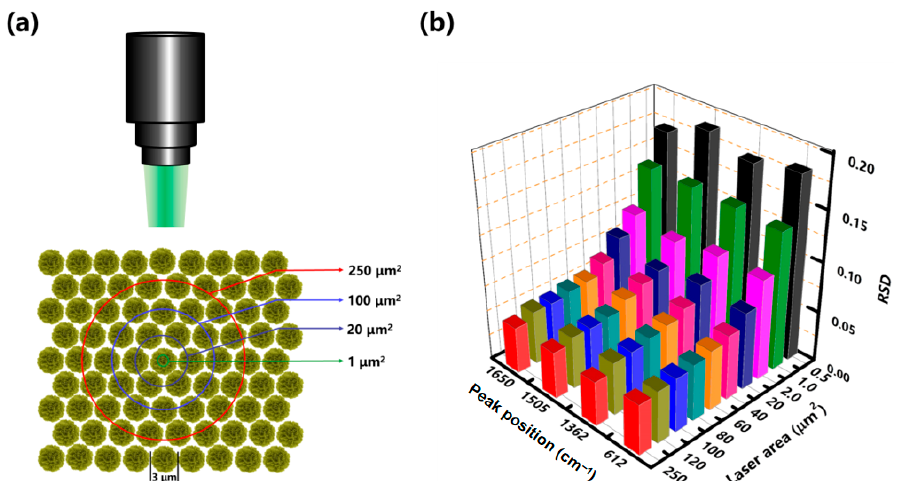
Figure 10. The SERS signal reproducibility evaluation of 3D hierarchical Au/CuS hybrid substrate. ( a ) Schematic illustration of SERS measurements with different LSAs on the hybrid substrate by confocal microprobe Raman spectrometer. ( b ) The RSD values of the four characteristic peaks of R6G molecules at 621, 1362, 1505, and 1650 cm − 1 obtained with different LSAs.